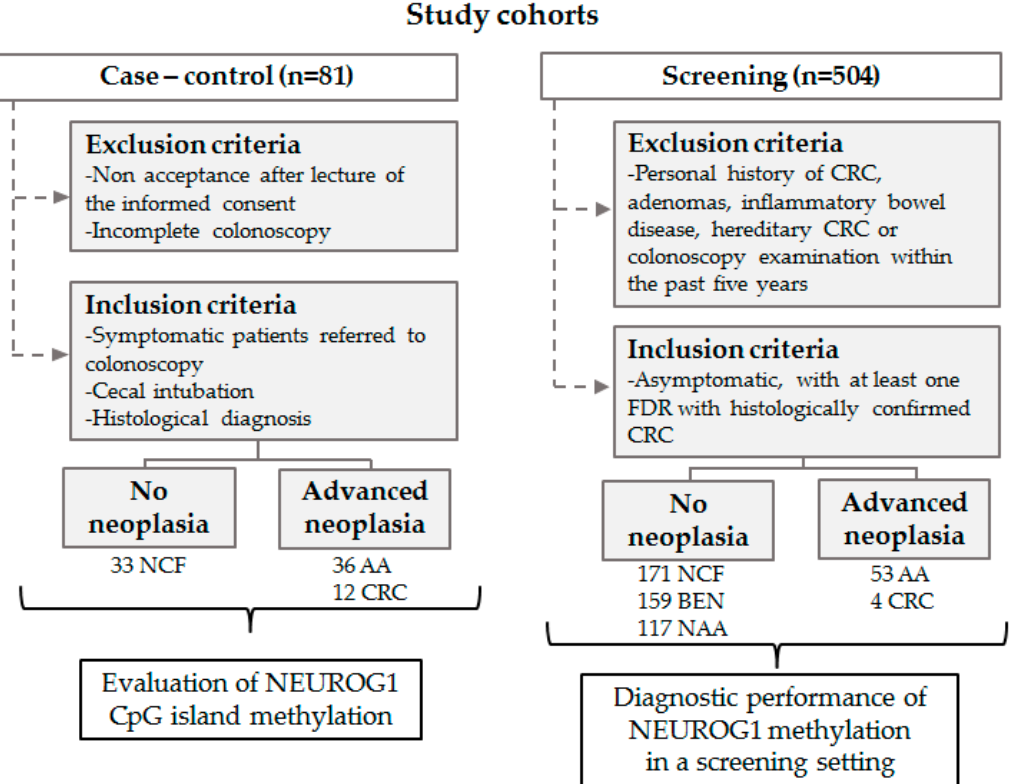
Figure 1. Study design flow ‐ chart. FDR: first ‐ degree relative; NCF: no colorectal findings; BEN: benign pathology; NAA: non ‐ advanced adenomas; AA: advanced adenomas; CRC: colorectal cancer.